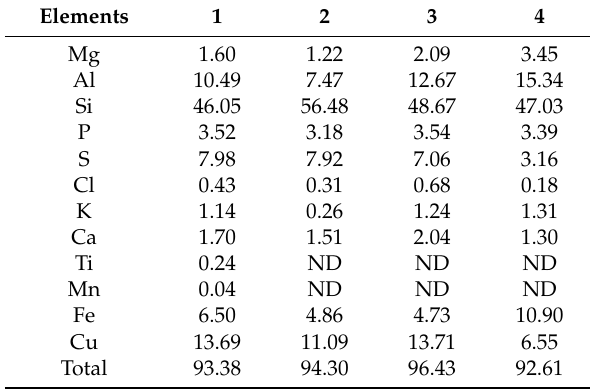
Table 3. Results of SEM-EDS semi-quantitative analyses of dried colonies of Pectinatella magnifica collected from Kahokugata Lake in July and September 2016. The unit is mass %.